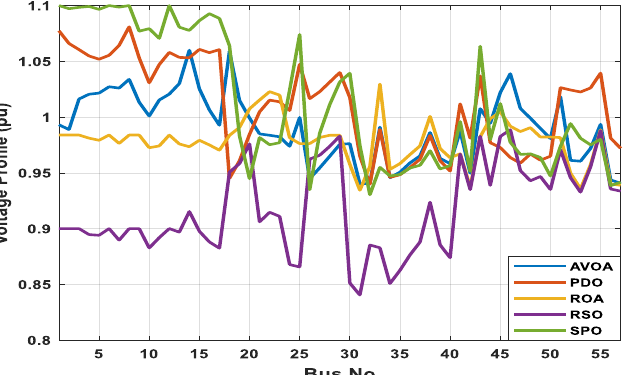
Figure 19. The AVOA voltage profile with the other compared methods for case 8.